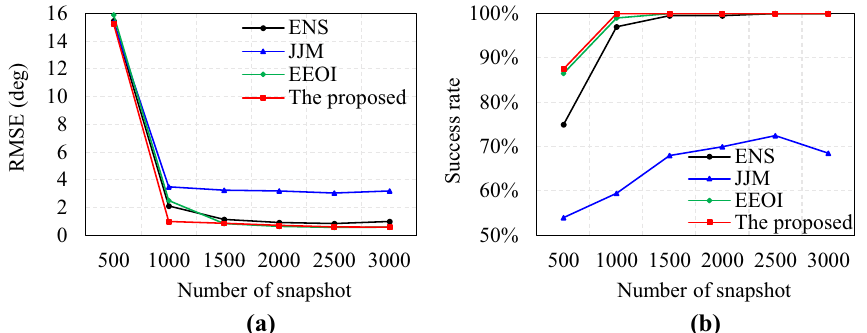
Fig. 6 RMSE or success rate of DOA estimation versus different numbers of snapshots. a RMSE. b Success